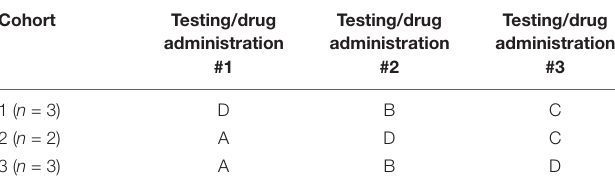
TABLE 1 | Balanced cross-over design for drug administration across testing